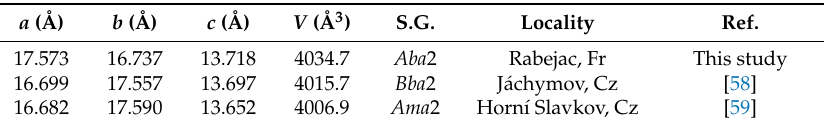
Table 15. Unit-cell parameters of